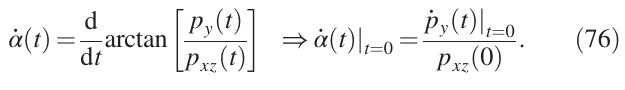
FIG. 11. The red (blue) curve shows the initial slope as a function of 25 random values of ϕ and ϕ , using a field S x 0 rf ¼ 10 3 . The simulated data are fitted amplification factor f ampl using the functions indicated in the inset. The resulting parameters are listed in Table IV. Each data point is obtained from a graph like the one shown in Fig. 9, but for 10 000 turns and 501 points.